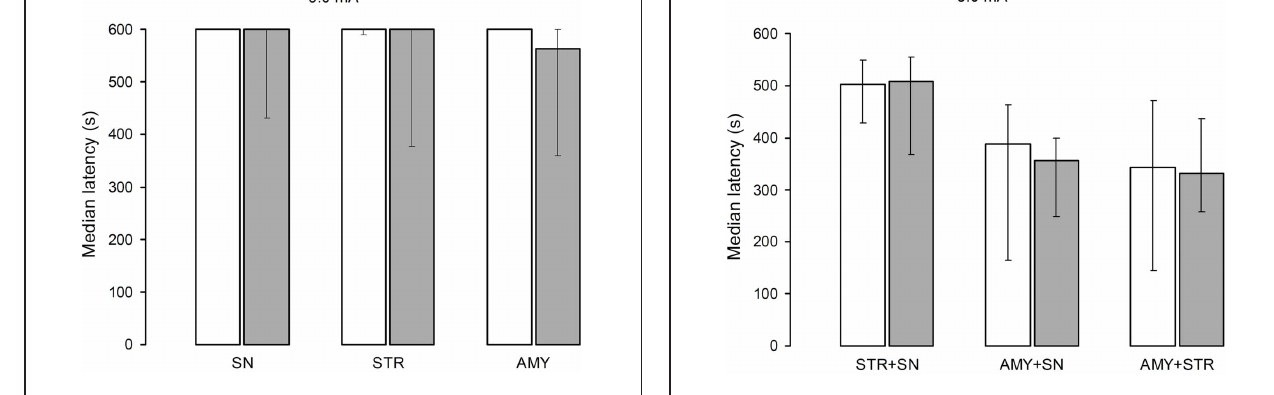
FIGURE 5 | Median retention scores (with interquartile range) of groups of rats trained in one-trial inhibitory avoidance and injected with either isotonic saline solution (open bars) or 2% lidocaine (filled bars). No significant differences among the groups trained with 3.0mA were found after simultaneous infusion of lidocaine or isotonic saline solution STR + SN, AMY + SN, or AMY +